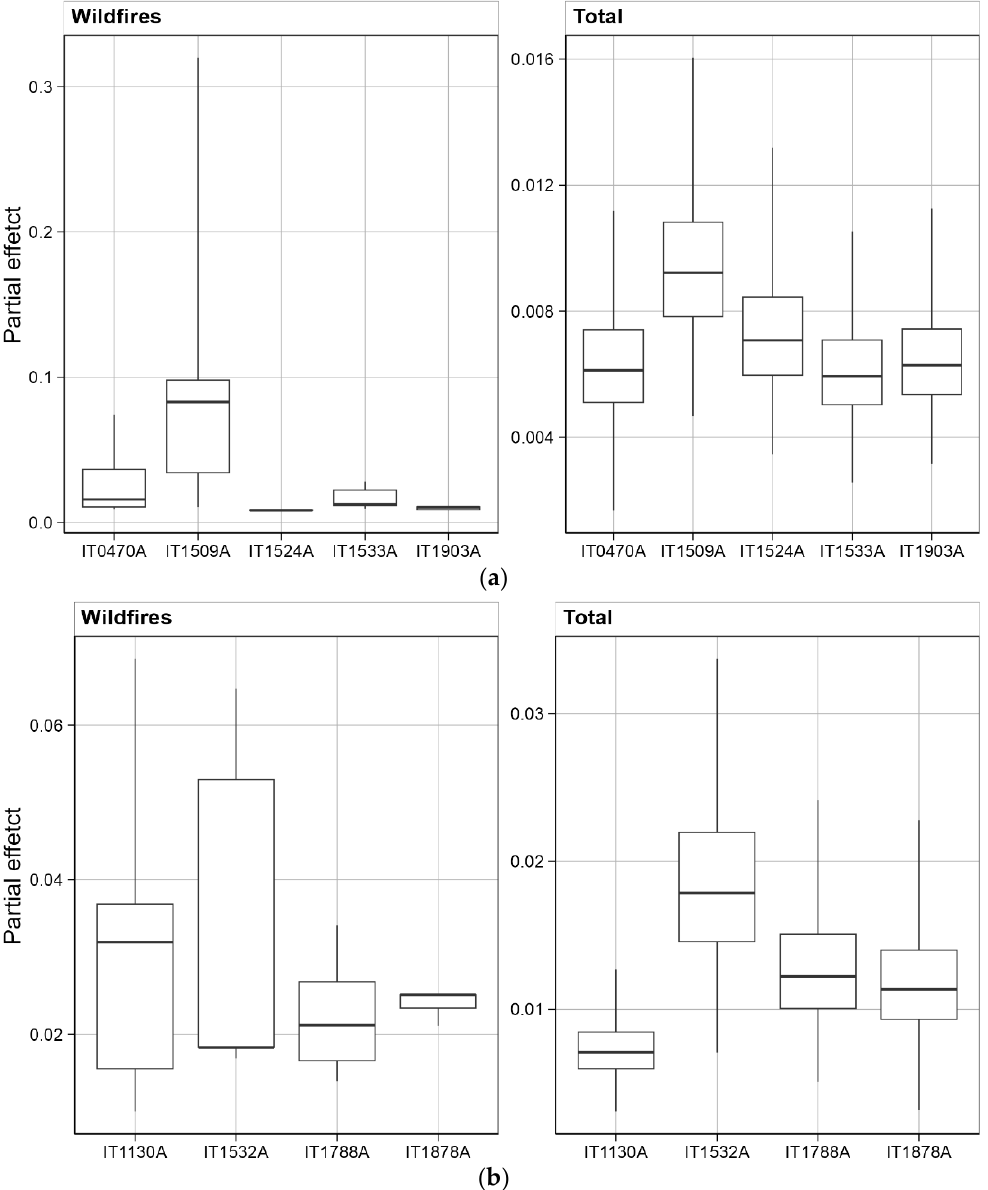
Figure 4. Relative uncertainty for ( a ) PM 10 -models, total (right) and wildfire partial contribution (left), median value is represented by bold line; ( b ) PM 2.5 -model, total (right) and wildfire partial contribution left), outliers omitted (see Figures S9 and S10 for boxplot with outliers), median value is represented by bold line.